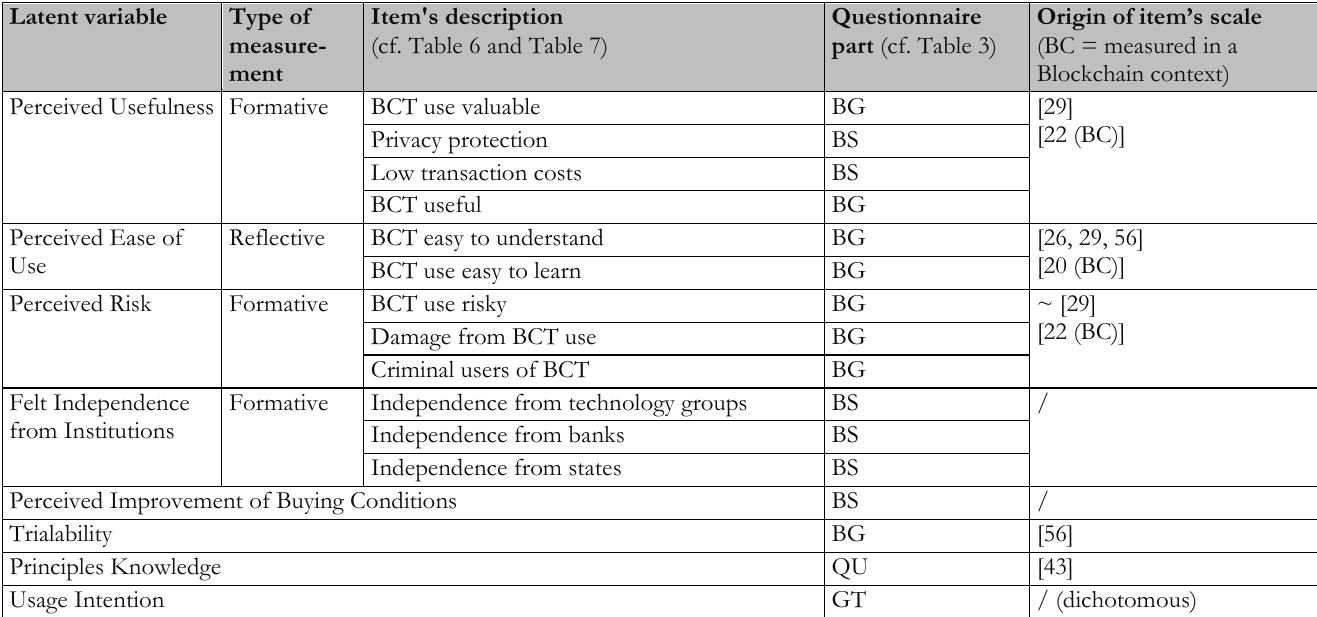
Table 4. Measurement models in the Structural Equation Model.